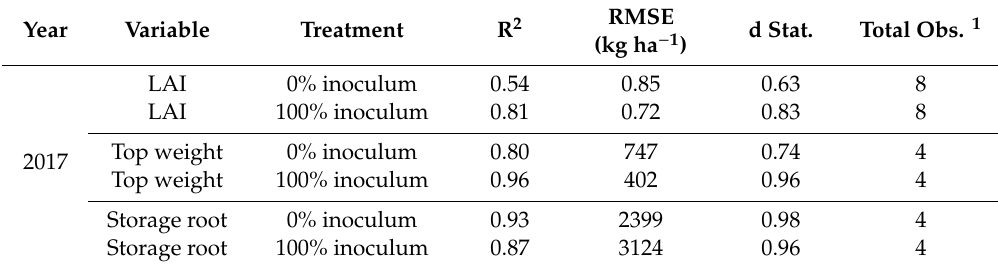
Table 6. Detailed statistics for simulated and observed values of LAI (m 2 m − 2 ), top weight (DM) kg ha − 1 , and storage root weight (DM) kg ha − 1 for the evaluation treatments 0% and 100% inoculum in 2017.